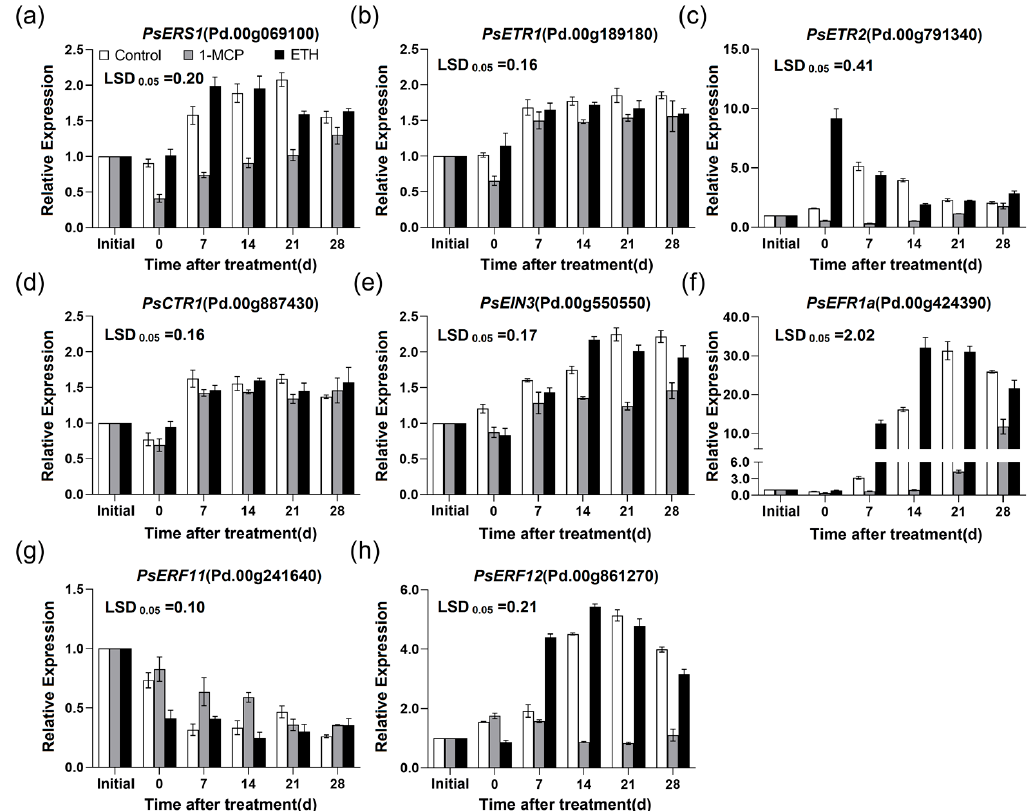
Figure 6. Effects of 1-MCP (1.0 μ L L − 1 ) and ETH (100.0 μ L L − 1 ) treatments on the expression profiles of genes associated with ethylene signal transduction in ‘Friar’ plum fruit under 10 °C storage. ( a – h ) Relative expression of PsERS1 , PsETR1 , PsETR2 , PsCTR1 , PsEIN3 , PsERF1a , PsERF11 and PsERF12 . “Initial” represents the time point before ethylene and 1-MCP treatments. The vertical bar represents the standard error while the LSD values show significant differences at the 0.05 level.